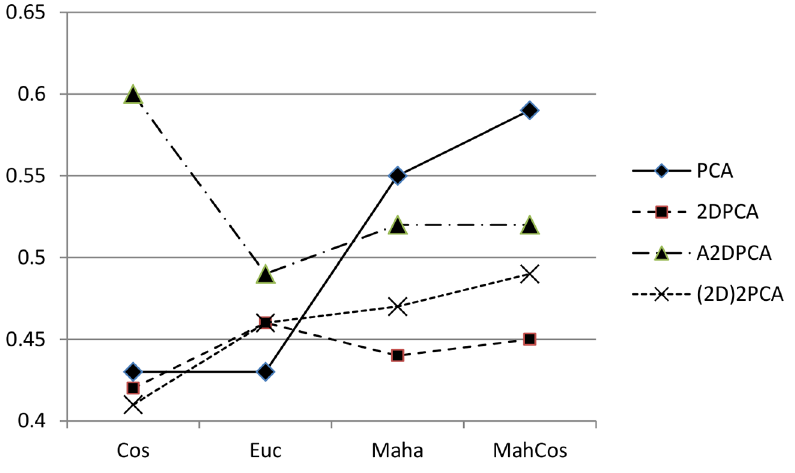
Figure 4. Average recognition rates of PCA based algorithms against distance metrics for FERET. doi:10.1371/journal.pone.0056510.g004 PLOS ONE |